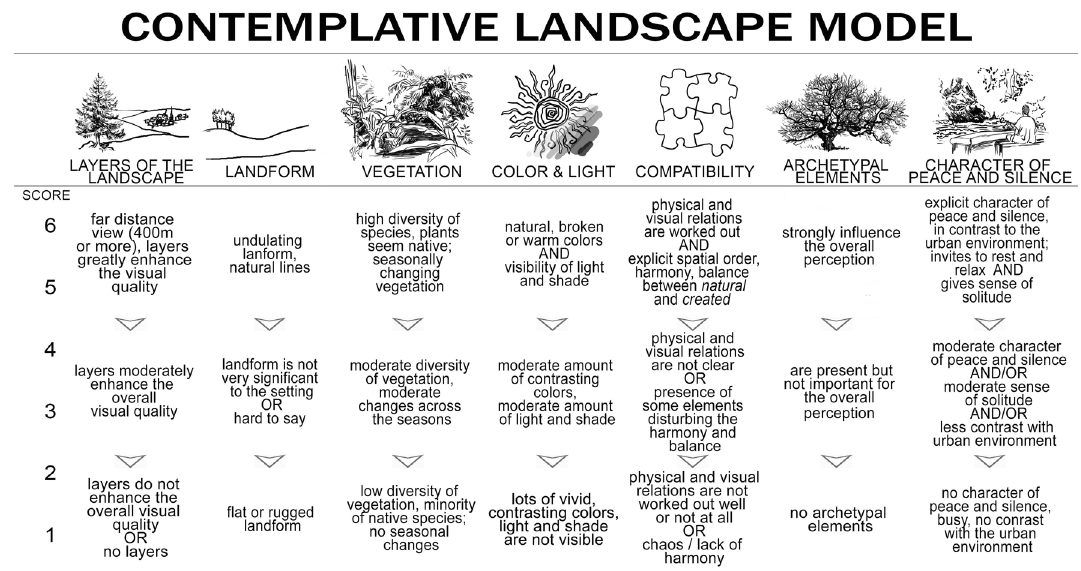
Figure 1. Contemplative Landscape Model with seven key-components and scoring system based on 1–6-point scale. Adapted from 32